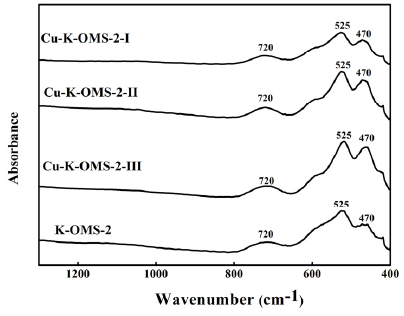
Figure 2. FTIR spectra of K-OMS-2, Cu-K-OMS-2-I, Cu-K-OMS-2-II, and Cu-K-OMS-2-III.